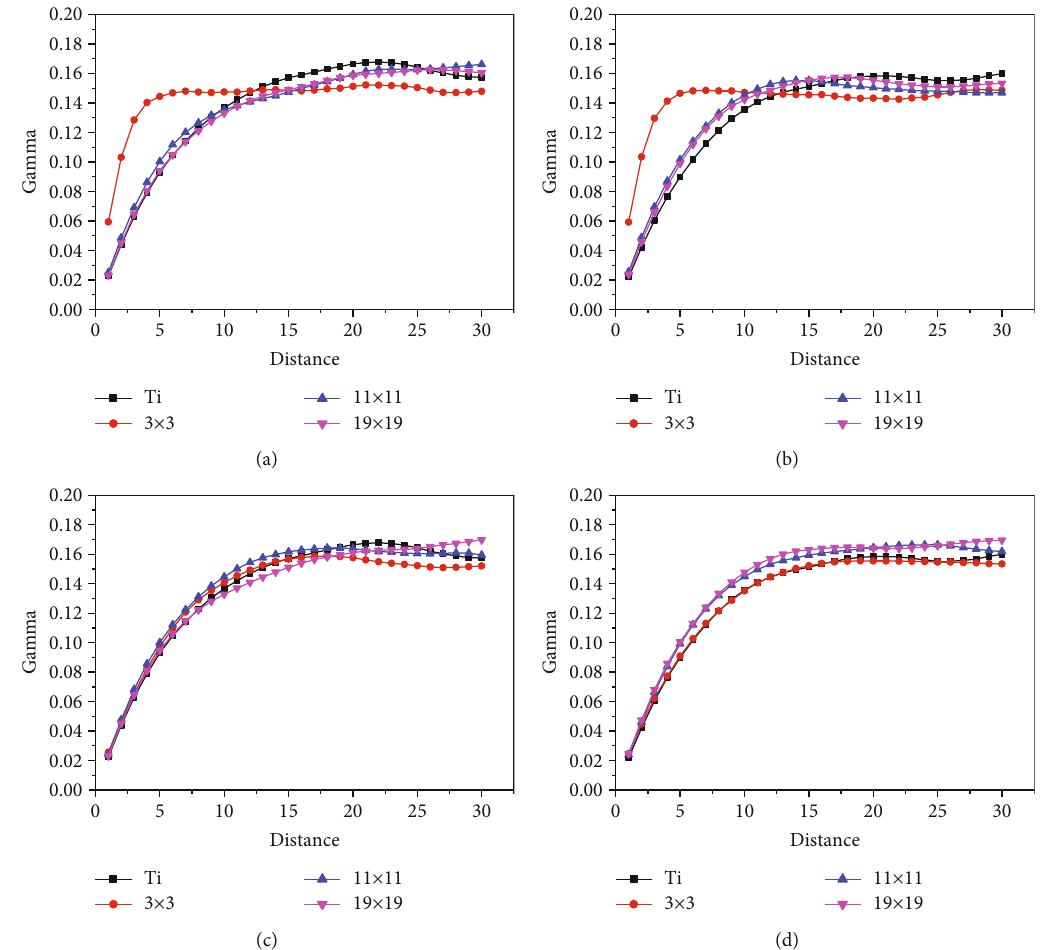
Figure 9: Experimental variograms for indicator function of pore: (a) single-grid scheme x direction; (b) single-grid scheme y direction; (c) multiple-grid scheme x direction; (d) multiple-grid scheme y